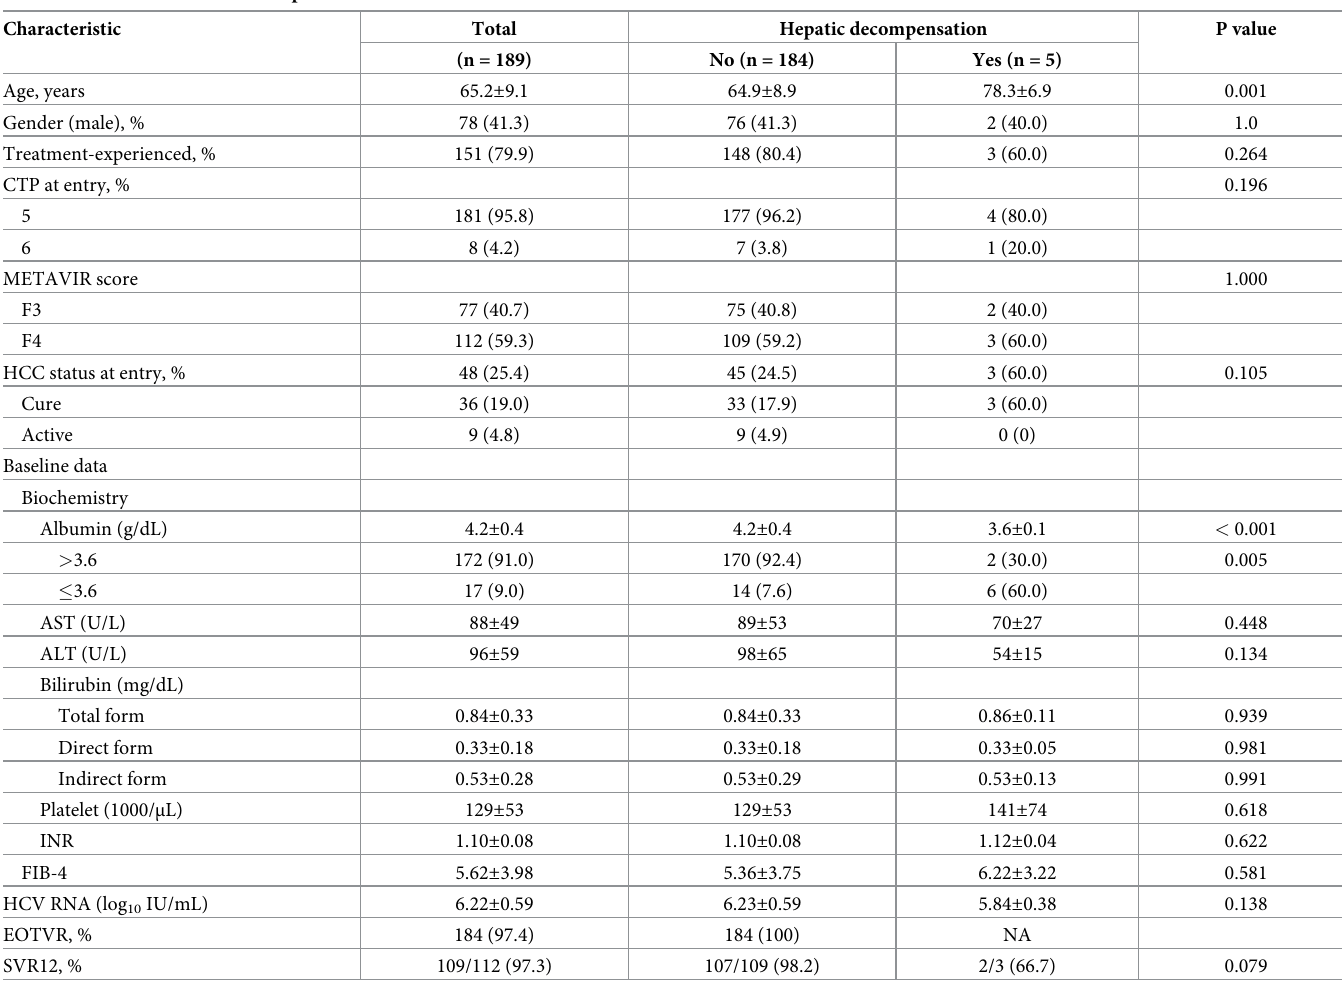
Table 1. Clinical characteristics of patients treated with